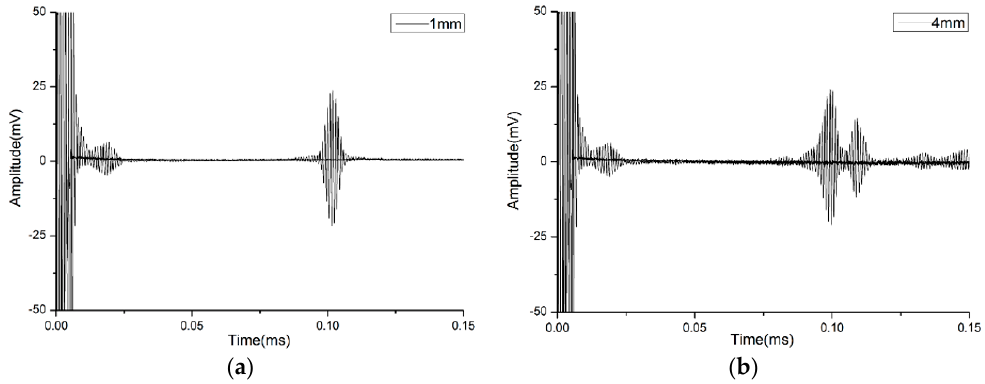
Figure 10. The reception signals of No. 1 and No. 2 waveguide bars: ( a ) Thickness 1 mm; ( b ) Thickness 4 mm.